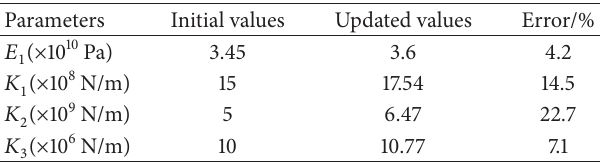
Table 8: Parameters change before and after updating based on the response surface